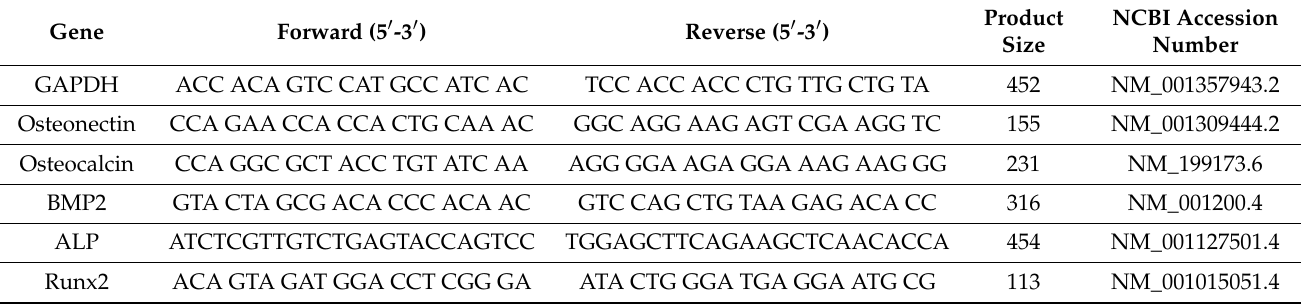
Table 2. Reverse transcriptase-polymerase chain reaction (RT-PCR) primers sequences.